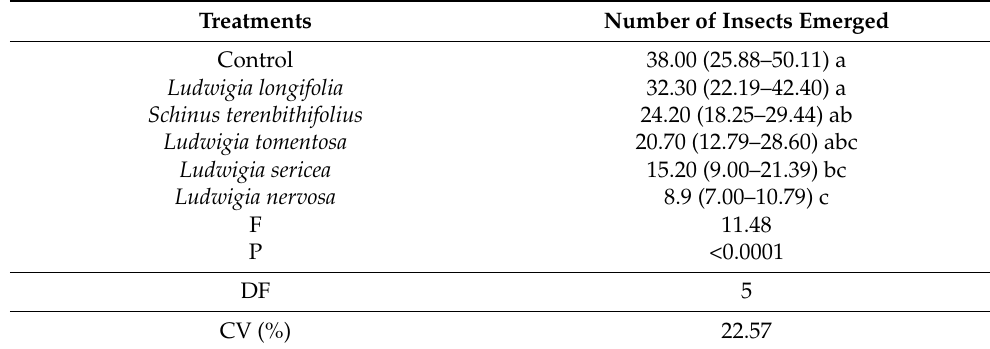
Table 3. Number of insects emerged after 60 days of Sitophilus zeamais infestation (no-choice test), in thirty grams of maize treated with 10% aqueous extract of five plants and one control (water). Dourados,